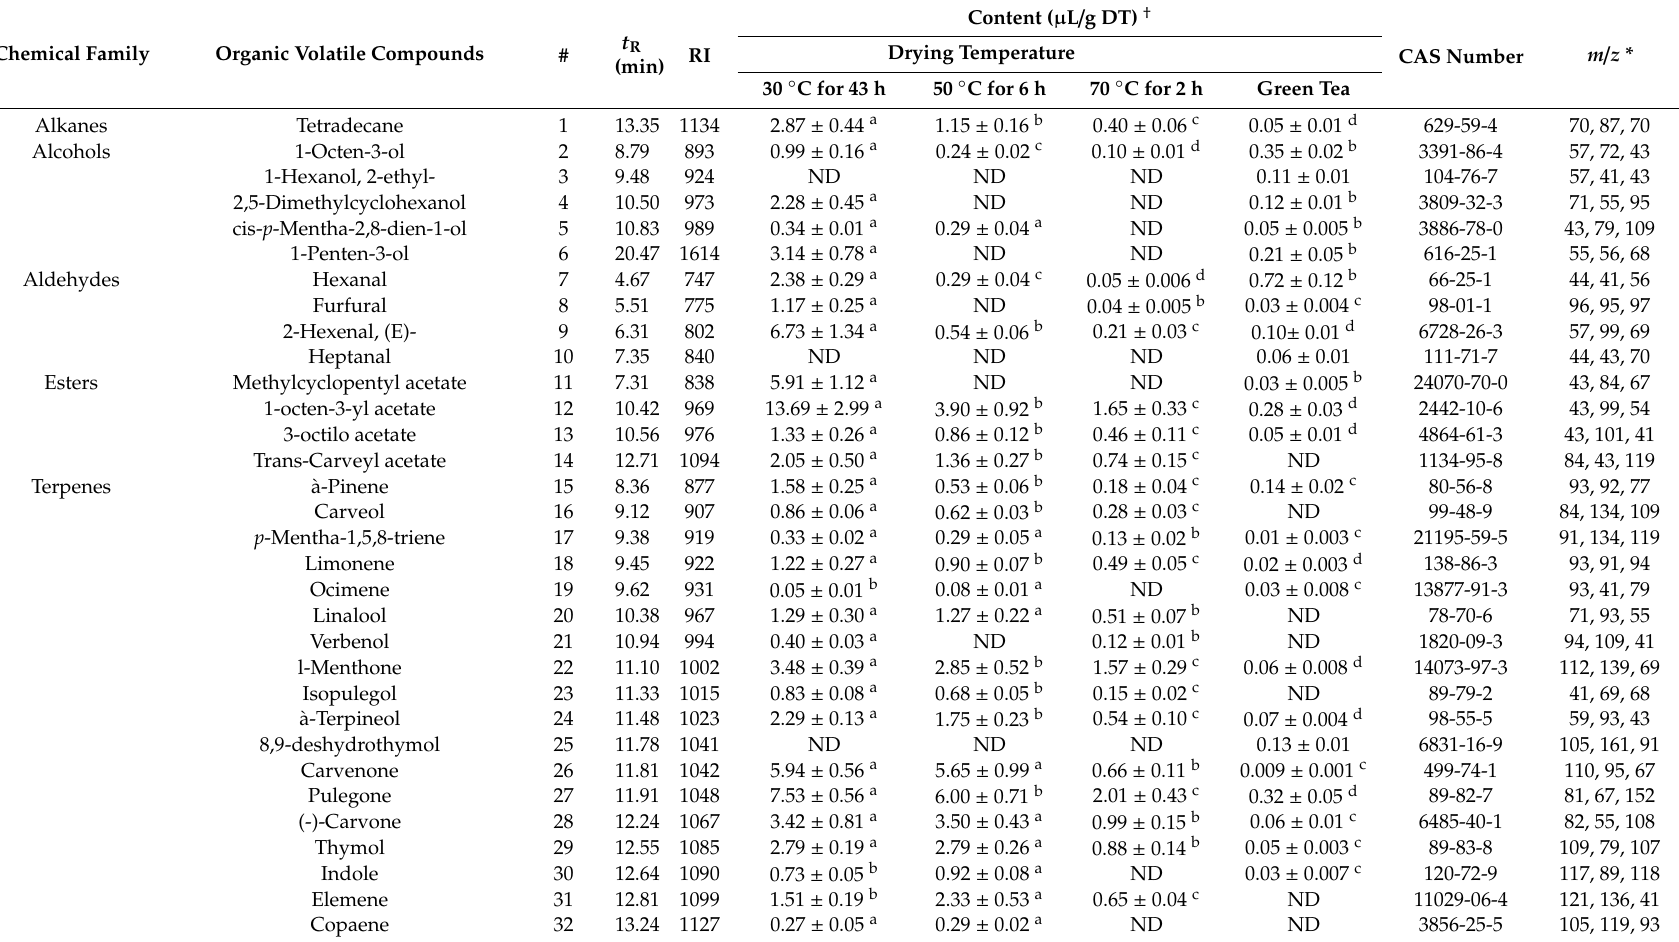
Table 1. Volatile organic compounds (VOCs) identified from Cunila polyantha samples dried at different temperatures and commercial green tea samples ( Camellia sinensis ).